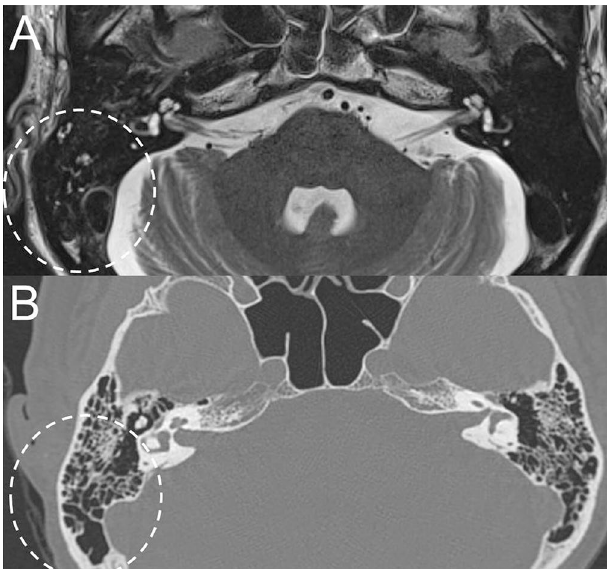
Figure 4. Comparison between temporal bone MRI and TBCT in a representative case of Ramsay Hunt syndrome with mastoid effusion on the right side. Non-contrast axial T2-weighted image at the level of IAC and mastoid air cells shows high signal intensity from the fluid in the right mastoid suggesting mastoid effusion (dotted circle, A ), which was not easily identifiable in TBCT (dotted circle, B